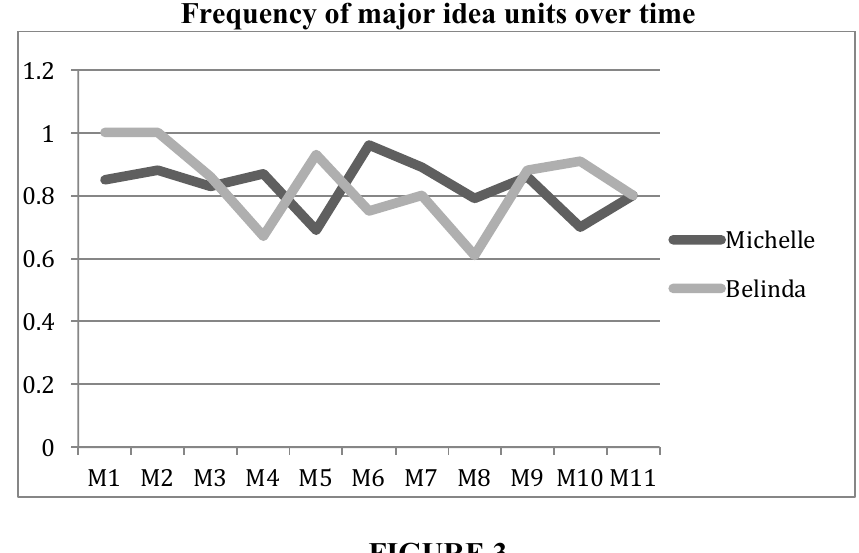
Frequency of minor idea units over